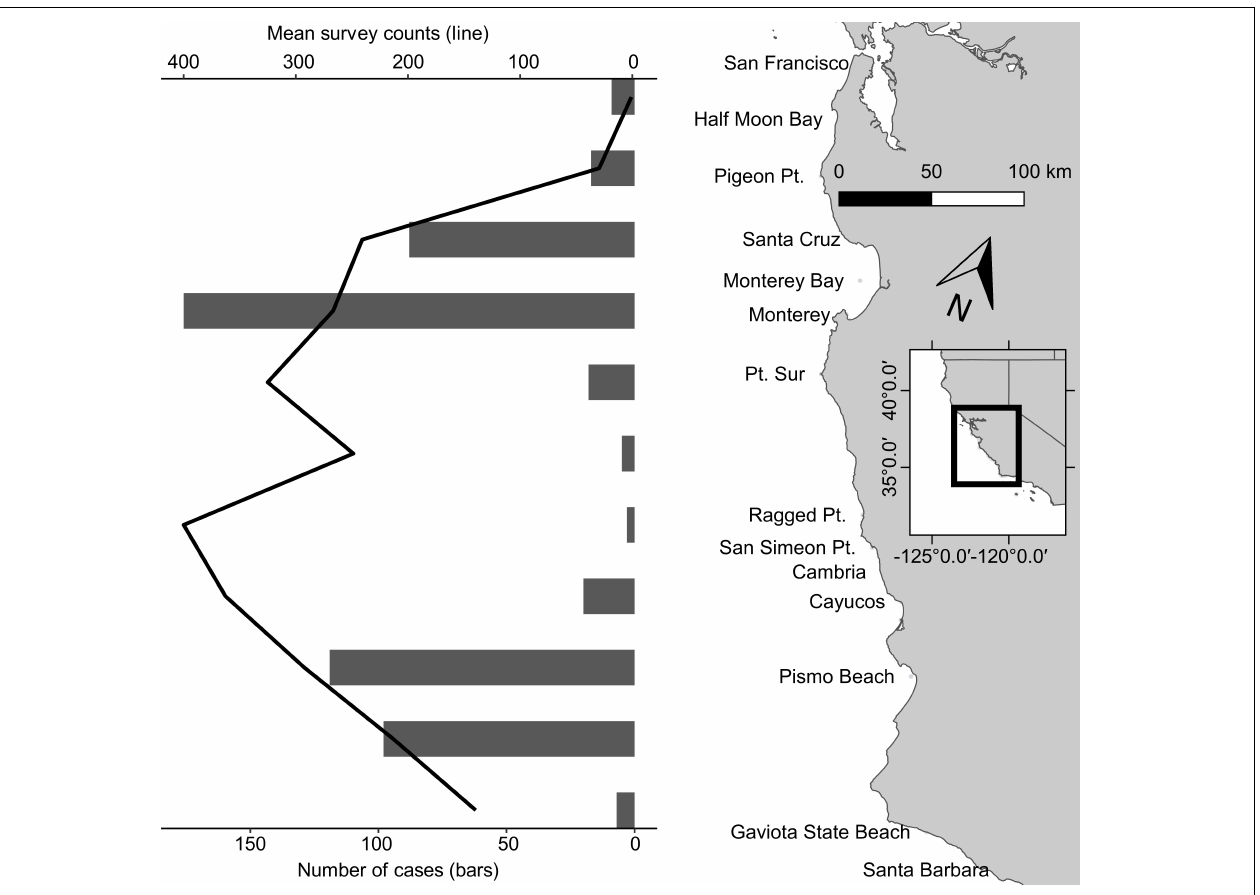
FIGURE 2 | Coastal California, United States stranding patterns from San Francisco Bay south to Santa Barbara for southern sea otter ( Enhydra lutris nereis ) carcasses examined 1998–2012 for this study (black bars). The superimposed black line is an index of the sea otter population during the same years across this same geographical area; note that although the sea otter population was high in the center of the range (Big Sur Coast), carcass recovery was low because this region is relatively sparsely populated and has few beaches to facilitate post-stranding carcass recovery. At center right is a small inset map of central California; the black-outlined portion of the inset shows the location of the study area (enlarged and shown in light gray at right center) along the California